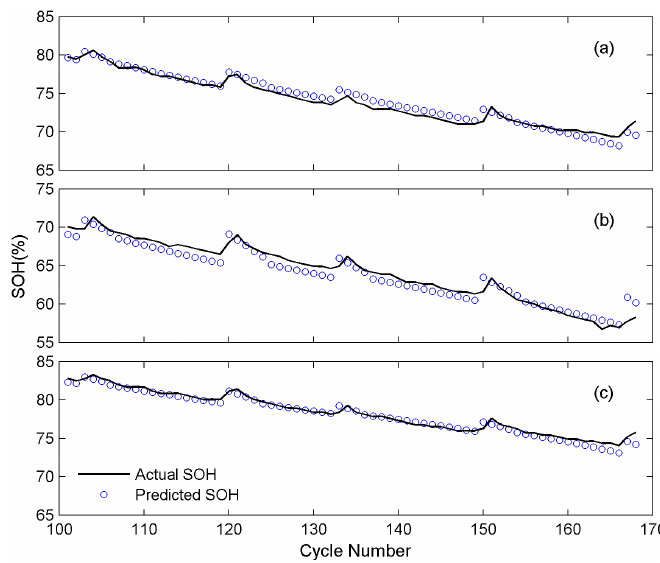
Figure 9. Overall prediction results of SOH: ( a ) battery No. 5; ( b ) battery No. 6; and ( c ) battery No. 7. Two criteria, mean absolute percentage error ( MAPE ) and root mean square error ( RMSE ), are adopted to evaluate the prediction performance of different methods.